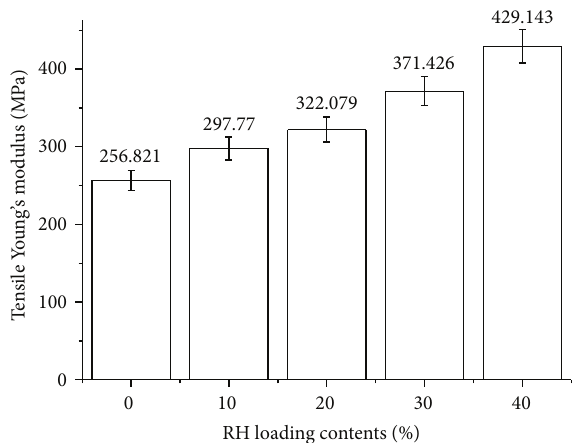
Figure 1: Tensile Young’s modulus of composites with different loading of rice husk